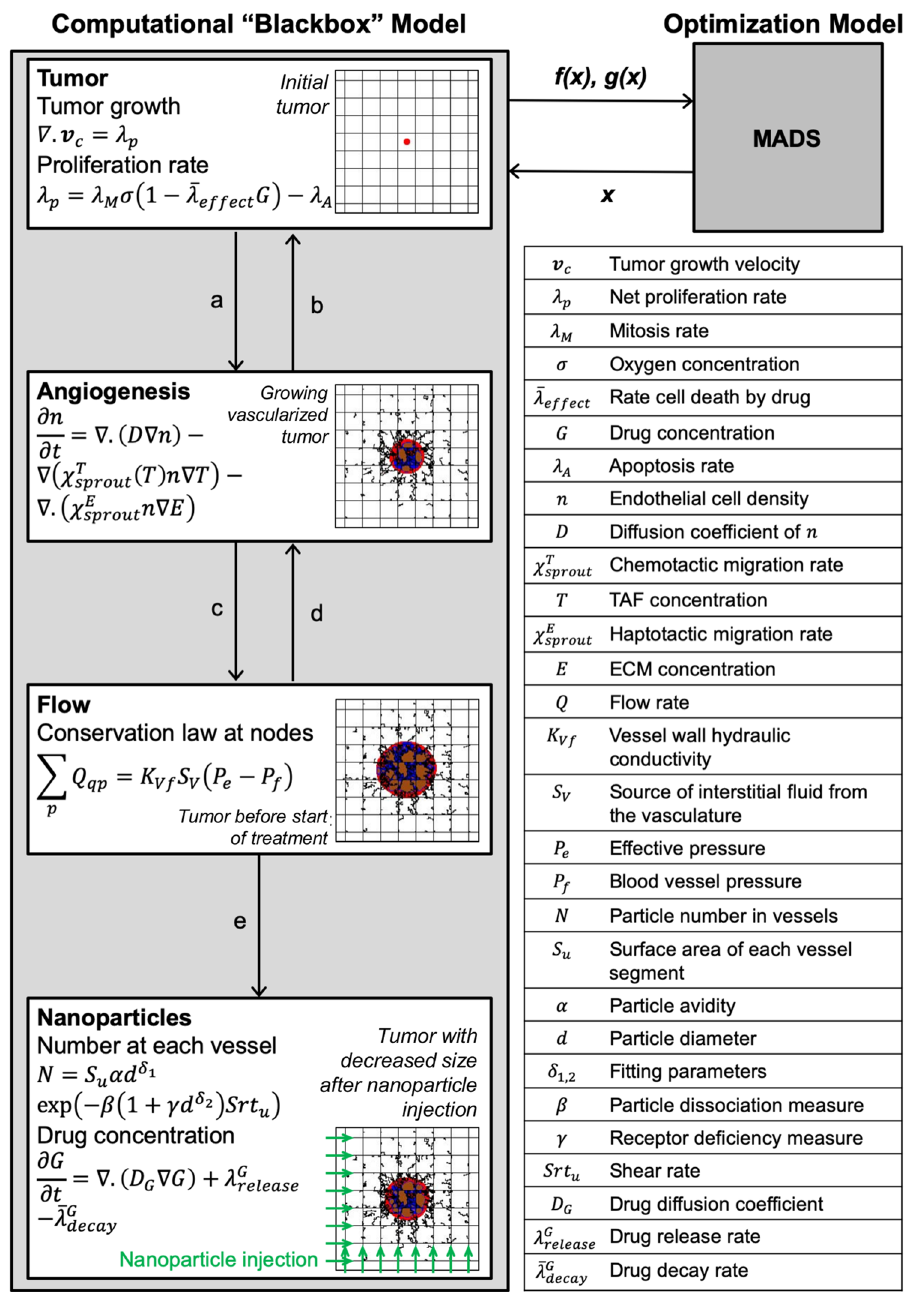
Figure 4. Hybrid framework for optimizing nanoparticle mediated drug delivery. The framework couples a computational “blackbox” model of vascularized tumor growth and nanoparticle treatment 7,25 with an optimization model based on the mesh adaptive direct search (MADS) algorithm 26,27 . The computational model 25 uses a nanoparticle design ( x ) selected by MADS and evaluates the objective function f(x) and the constraints g(x) . These values are used by MADS to recommend a new trial point for the computational model. This process iterates until the objective function is optimized, so that the result of the hybrid framework generates optimal nanoparticle designs x * . In the computational model, multiple sub-models interact and exchange parameters, including: ( a ) angiogenic factors; ( b ) oxygen and nutrients; ( c ) location of capillary junctions; ( d ) wall shear stress, flow stimulus, and intravascular pressure; and ( e ) vessel radii, vessel surface areas, and flow rate. The tumor is displayed in the computational model at inception, after vascularization, before treatment and after treatment. Colors are as in Fig.